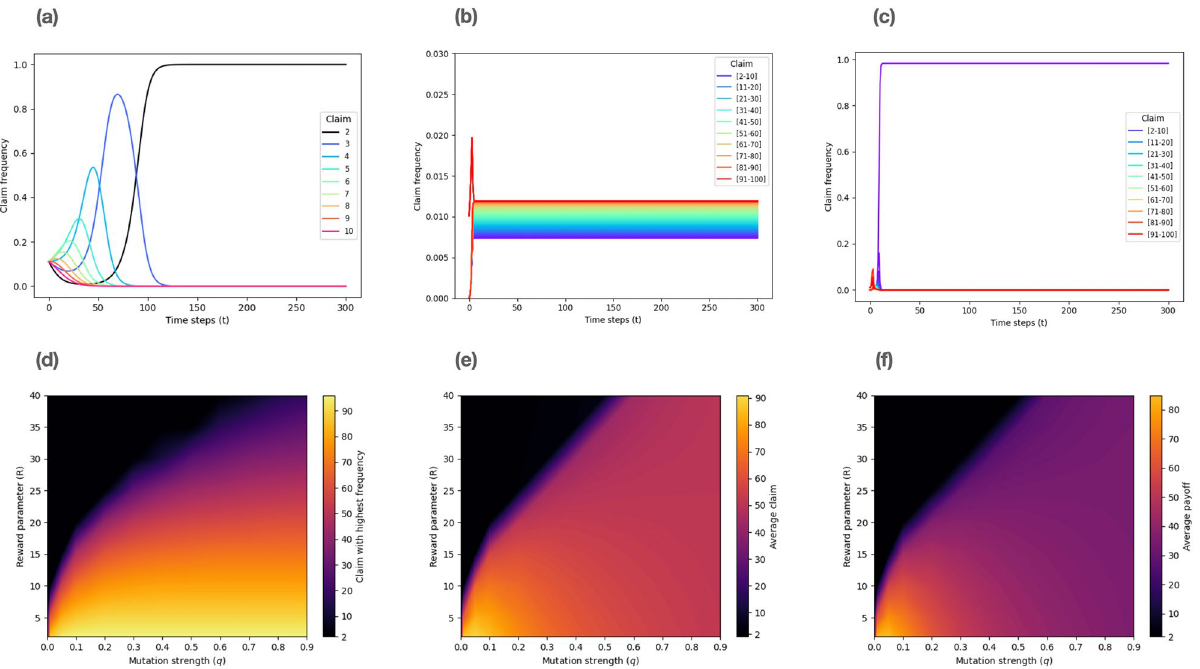
0 ). The = 30 , and 0.2 , R = =